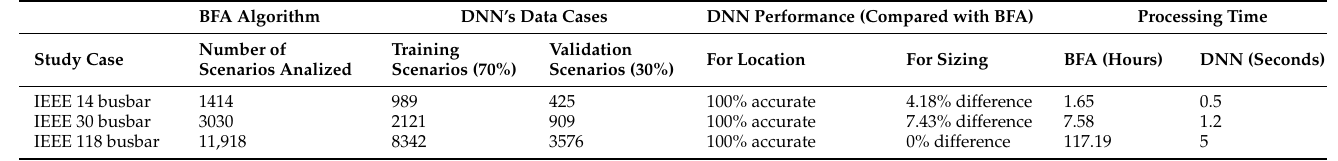
Table 3. Results comparison between the DNN and BFA for all study